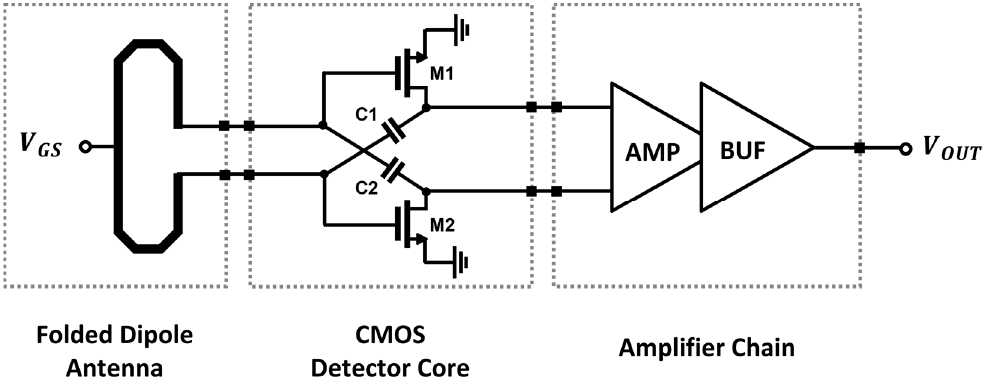
Figure 4. Block diagram of the CMOS detector-integrated circuit for detector unit pixel of the proposed array.